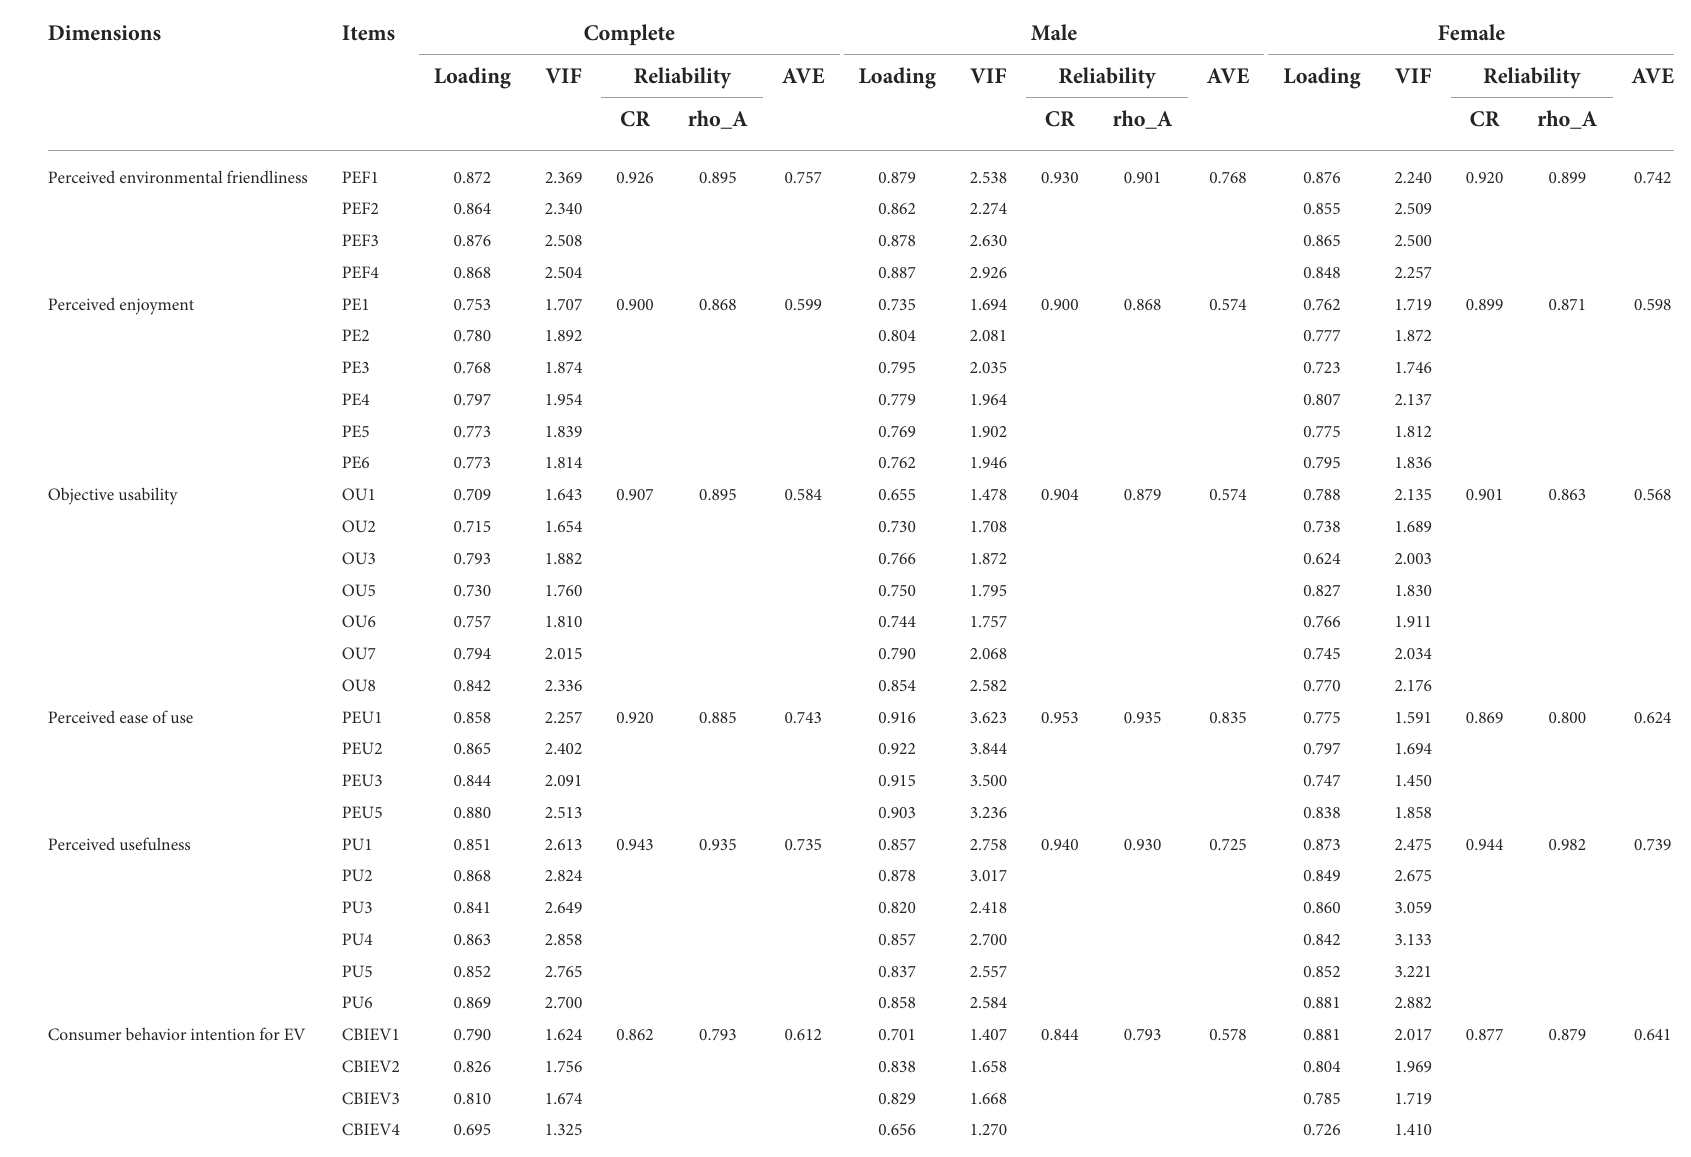
TABLE 4 Reliability and convergent